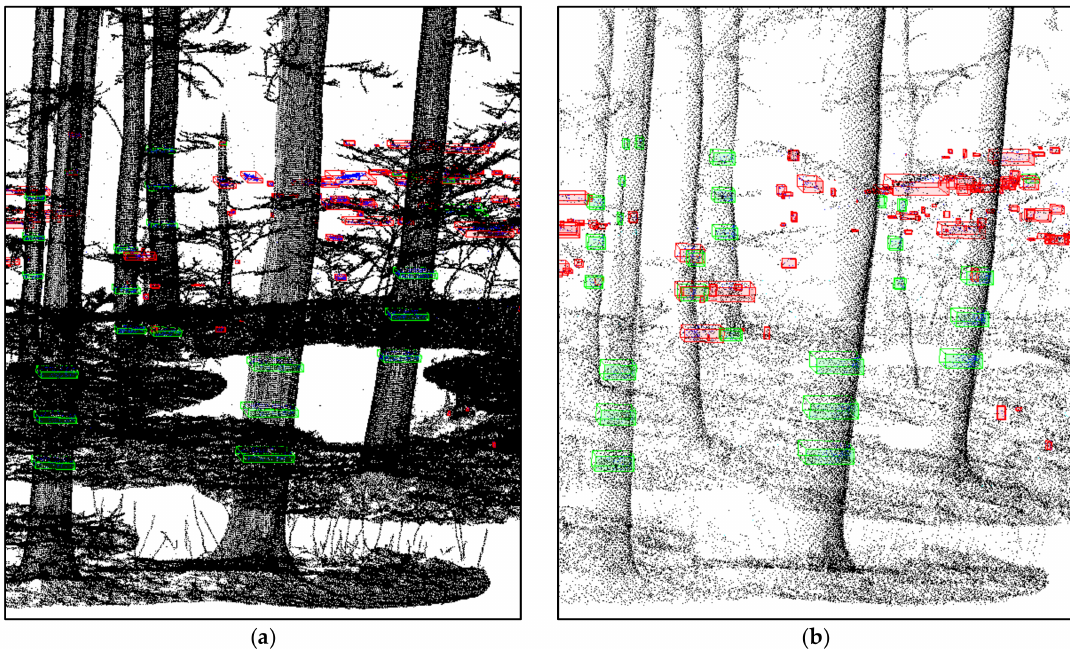
Figure A1. Leaf-off point clouds with detected tree objects in plot 1. Point clusters detected as ‘tree’ are shown with a green bounding box and rejected point clusters with a red bounding box. ( a ) TLS, ( b )